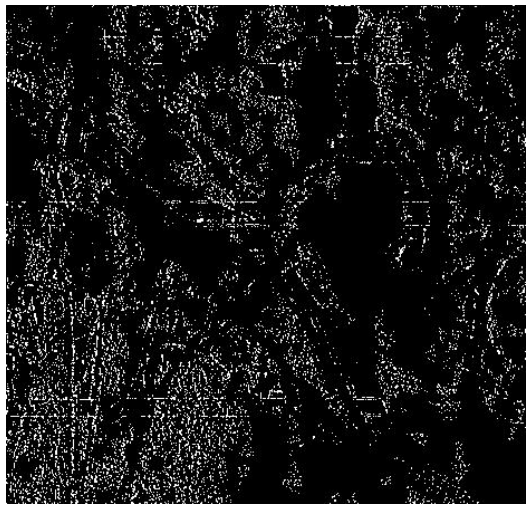
Figure 5. Non-oriented filter mask